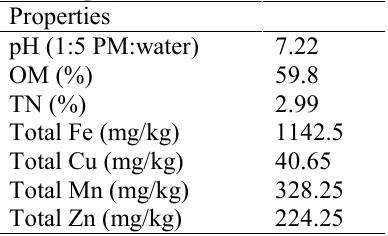
Table 2. Selected properties of poultry manure (pm)